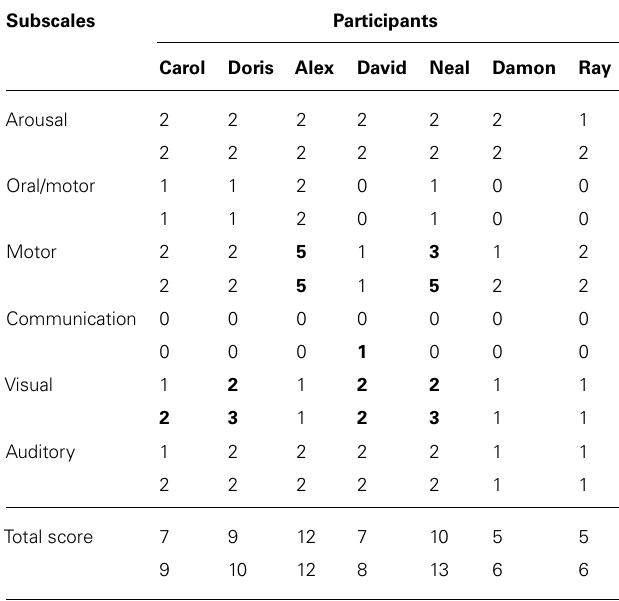
Table 1 | Participants’ scores on the first (upper number) and second (lower number) application of the CRS-R.